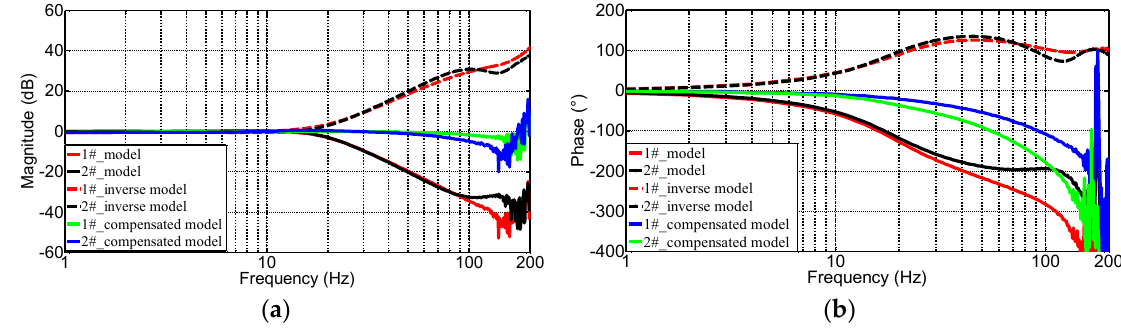
Figure 23. Frequency characteristics of identified models and designed inverse models. ( a ) Magnitude